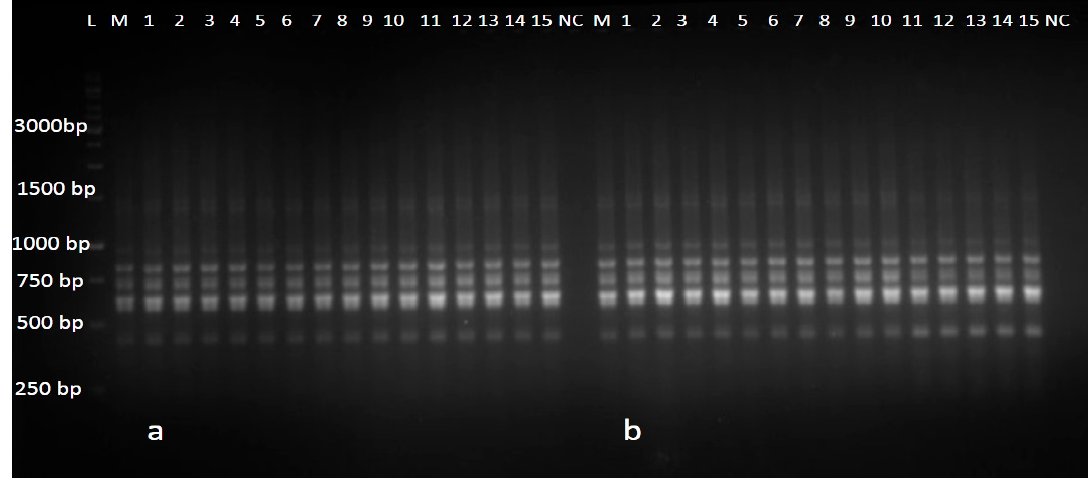
Figure 5. The evaluation of genetic fidelity of micropropagated H. Lupulus cv. Cascade plants with their mother plant by